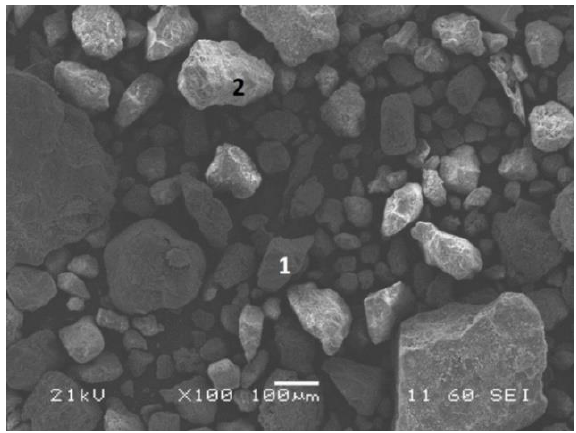
Figure 6. Scanning electron microscopy (SEM) image (×100) of the residue sample. Particles identified: copper pitch (1); chrysocolla (2).